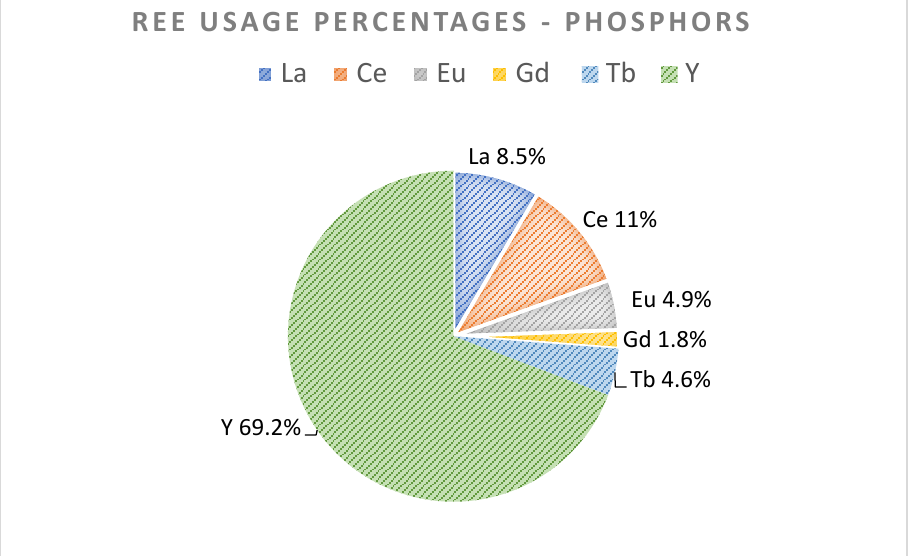
Figure 5. REE usage percentages in phosphors [3,13] (Royen et al., 2016). European feed for the important REE target in phosphors is estimated in the range of 140–2300 tons for Y, Tb, and Eu metals. In Table 5, in-use stock amounts for Y, Eu, and Tb for the year were reported by Guyonnet et al. [8]. Those of La, Ce, and Gd shown in percentage and in-use stock numbers of yttrium (arbitrarily chosen base case). Table 5. REE-specific in-use stock of lamp phosphors in Europe [8]. Y Eu Tb La Ce